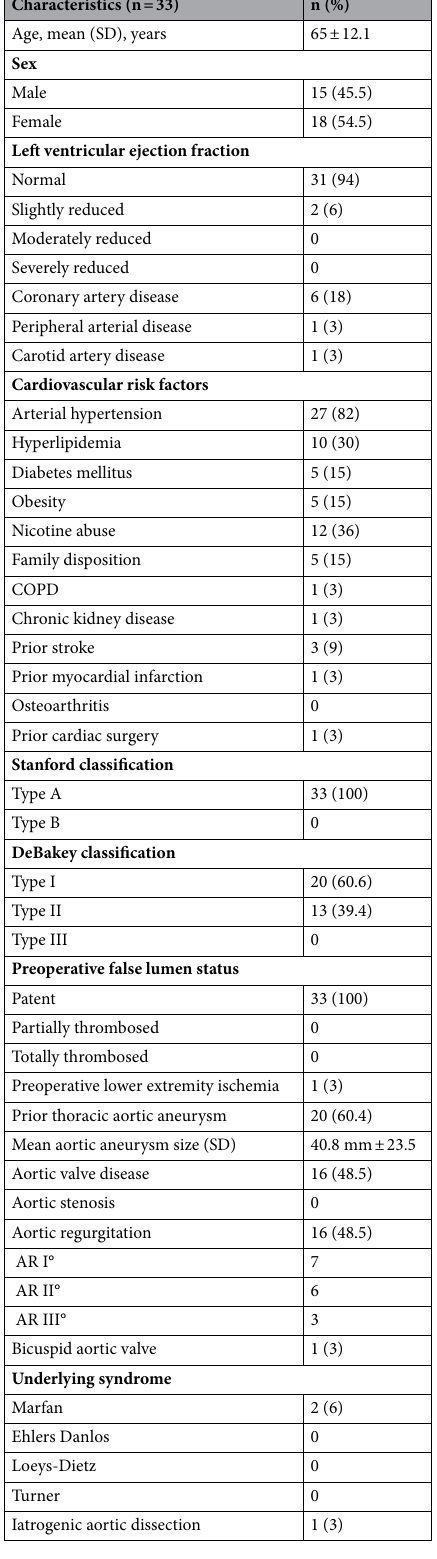
Table 1. Baseline characteristics and specific pathological features of patients with ATAAD. ATAAD acute type A aortic dissection, SD standard deviation, n number of patients, % percent of patients, COPD chronic obstructive lung disease, y years, AR aortic